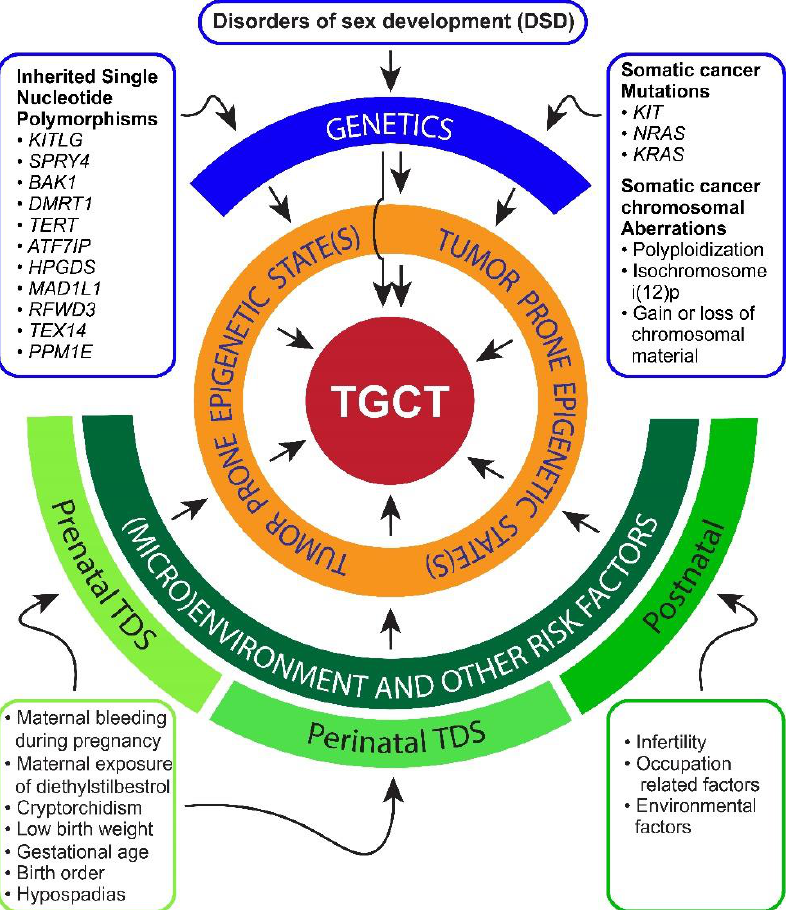
Figure 1. An epigenetic-centric view of testicular germ cell tumors (TGCT) etiology. While genetics undoubtedly play a role in TGCT development, epigenetic altering factors in the microenvironment of the testis from both internal and external sources may be a more important driving factor. The model also suggests that even inherited genetic germline variants and somatic cancer alterations may participate in establishing tumorigenic epigenetic state(s) of TGCTs. DSD, disorders of sex development, TDS, testicular dysgenesis syndrome.